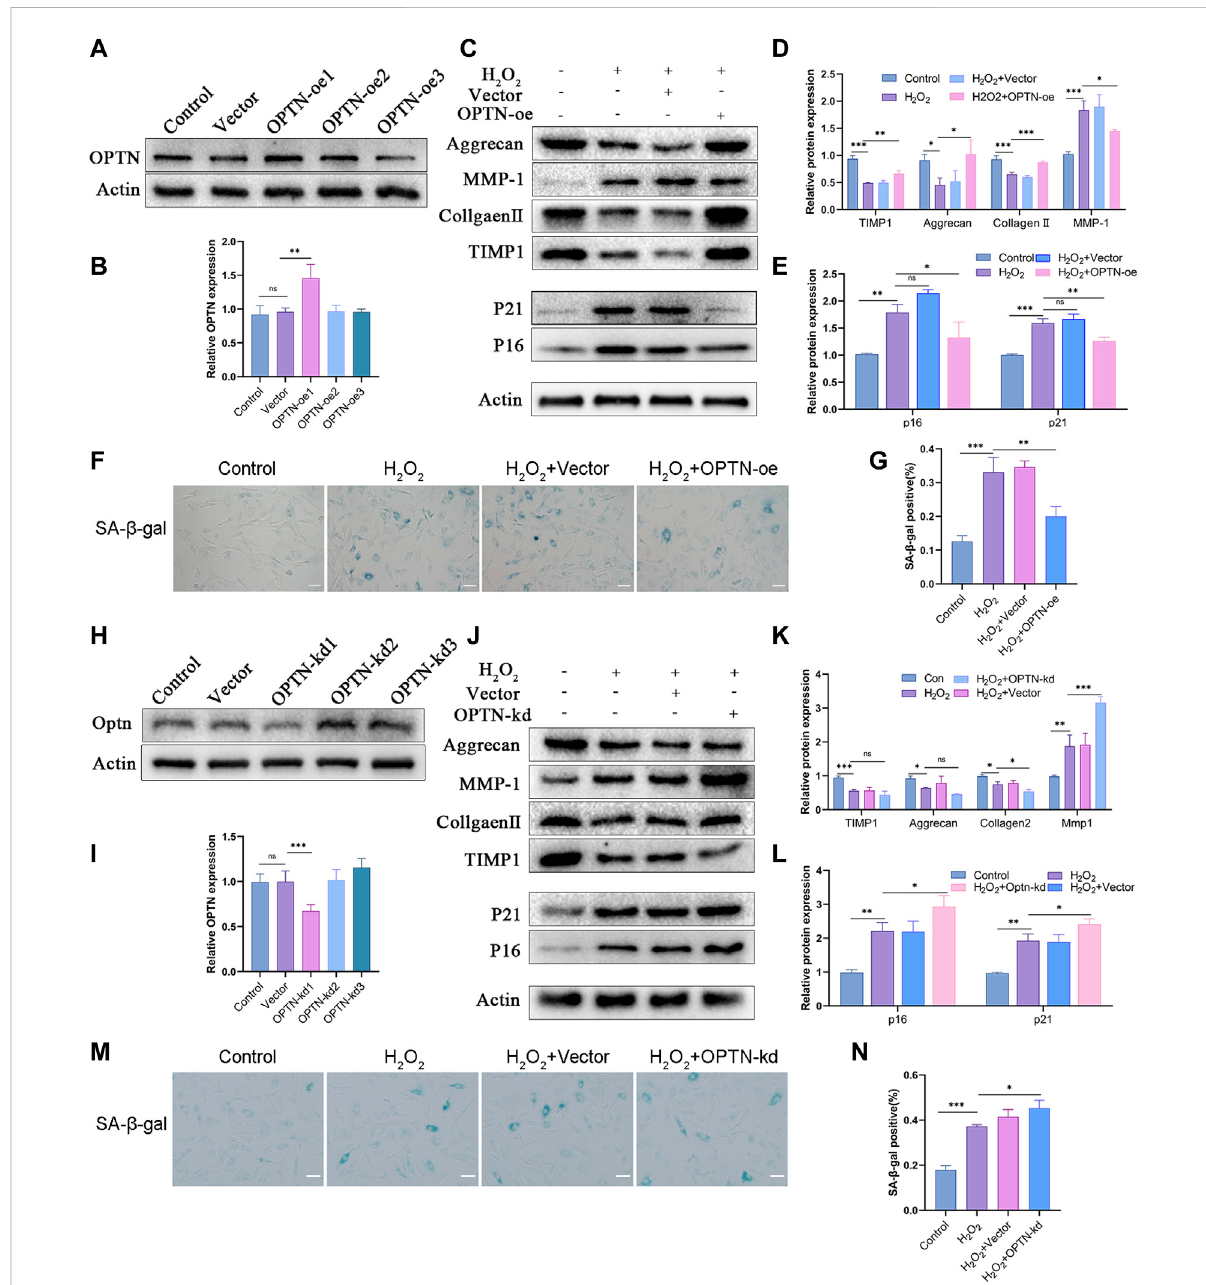
FIGURE 2 OPTN expression affects senescence and ECM homeostasis of H 2 O 2 -teated rat NPCs. (A – B) The expression of OPTN after same overexpression lentivirus transfection with different MOI (OPTN-oe1:15, OPTN-oe2:30, OPTN-oe3:60). (C – E) Western blot and quanti fi cation of Aggrecan,MMP-1,Collagen Ⅱ ,TIMP1,P21,P16inoverexpressionlentivirustransfectedratNPCsfollowedbyH 2 O 2 treatment. (F – G) Sa- β -galstaining was used to detect the senescence of overexpression lentivirus transfected NPCs followed by H 2 O 2 treatment (scale bar: 50 μ m). (H – I) The expression of OPTN after knockdown lentivirus transfection. (J – L) Western blot and quanti fi cation of Aggrecan, MMP-1, Collagen Ⅱ , TIMP1, P21, P16 in knockdown lentivirus transfected rat NPCs followed by H 2 O 2 treatment. (M – N) Sa- β -gal staining was used to detect the senescence of knockdown lentivirus transfected NPCs followed by H 2 O 2 treatment. All experiments were performed as means ± SD of 3 times in duplicates (scale bar: 50 μ m). * p < 0.05, ** p < 0.01, *** p < 0.001, ns p >